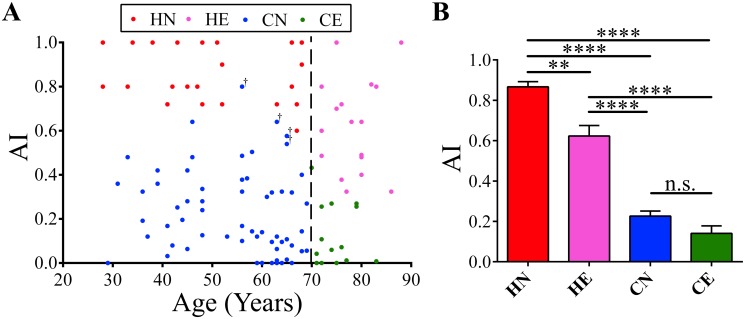

AI of healthy subjects (HN and HE) and cerebellar patients (CN and CE).(A) Distribution of AIs and ages for all the participants analyzed. AI tended to decrease and showed a widespread distribution in the HE group. Cerebellar patients (CN and CE) showed lower AIs than the age-matched healthy subjects (HN and HE). † indicates four pure parkinsonian MSA patients without clinical cerebellar signs. (B) Comparison of AI among the HN, HE, CN and CE groups. In all panels, red circles and columns represent HN; magenta, HE; blue, CN; and green, CE. **p < 0.01, ****p < 0.0001, Kruskal-Wallis test or Steel-Dwass test. Error bar represents SEM.